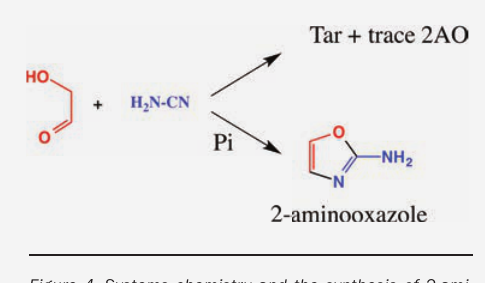
Figure 4. Systems chemistry and the synthesis of 2-ami- nooxazole. Glycolaldehyde (red) reacts with cyanamide (blue) to generate insoluble polymeric tar and trace quantities of 2-aminooxazole (2AO). However, in the presence of phosphate (Pi), acting as both a pH buffer and as an acid-base catalyst, 2AO is obtained in high